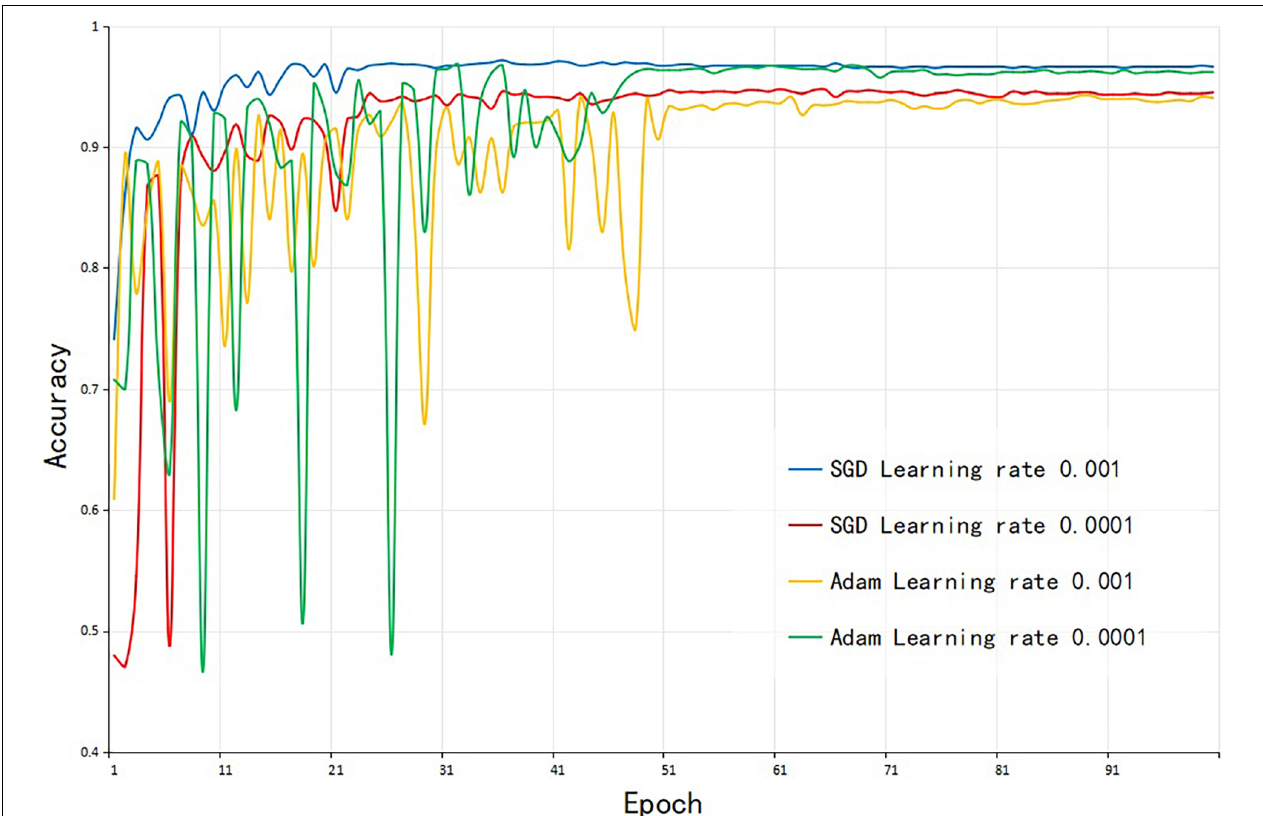
FIGURE 7 | The accuracy of Corn-seed-Net with different model